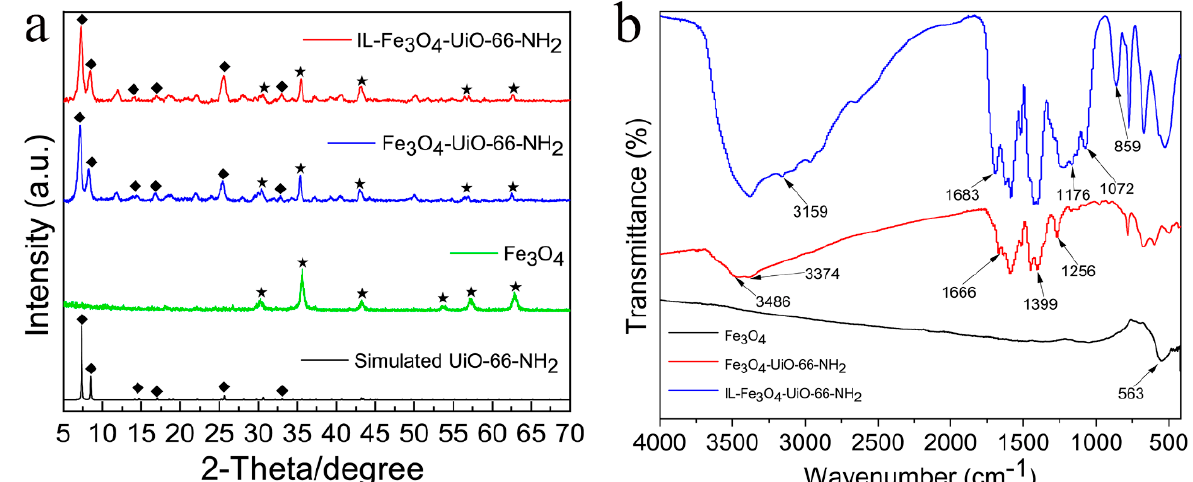
Figure 1. ( a ) XRD of simulated UiO-66-NH 2 (green), Fe 3 O 4 (black), Fe 3 O 4 @UiO-66-NH 2 (blue), IL-Fe 3 O 4 @UiO-66-NH 2 (red), ( ◆ indicates the diffraction peak of UiO-66-NH 2 , ★ indicates the diffraction peak of Fe 3 O 4 ); ( b ) FTIR spectra of Fe 3 O 4 (black), Fe 3 O 4 @UiO-66-NH 2 (red), and IL-Fe 3 O 4 @UiO-66-NH 2 (blue).